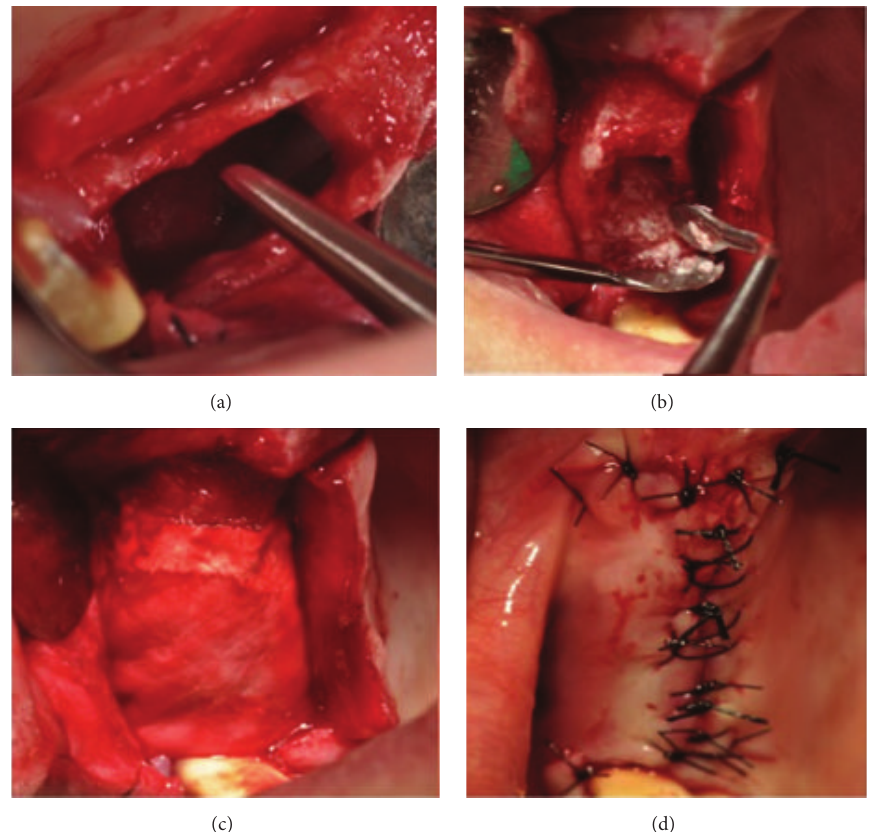
Figure 5: Clinical view of the sinus cavity (a). Cavity filled with autologous/heterologous material (b). Collagen sheet placed (c). Suture placed (d).